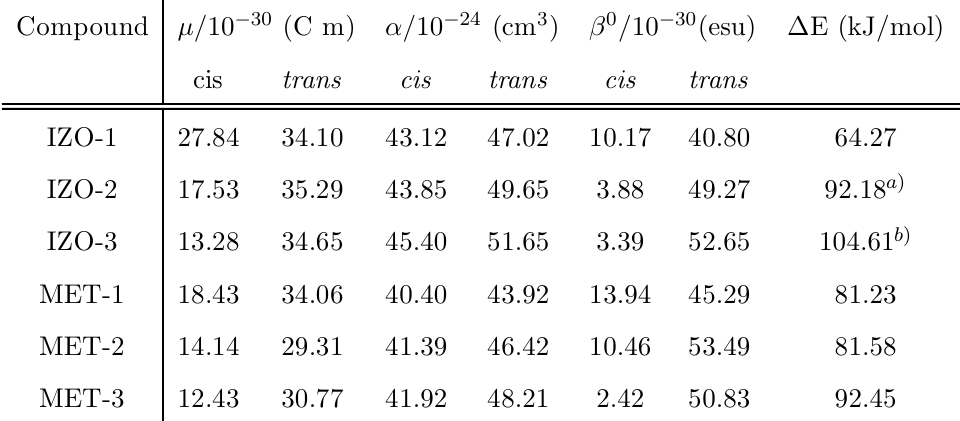
Table 1 Dipole moments, polarizability, › rst hyperpolarizability and potential energy di¬erence (¢E) of the trans and cis structures as calculated by GAUSSIAN. a ) B3LYP/6-31G: ¢E = 88.19 kJ/mol; b ) B3LYP/6-31G*: ¢E = 99.89 kJ/mol (single